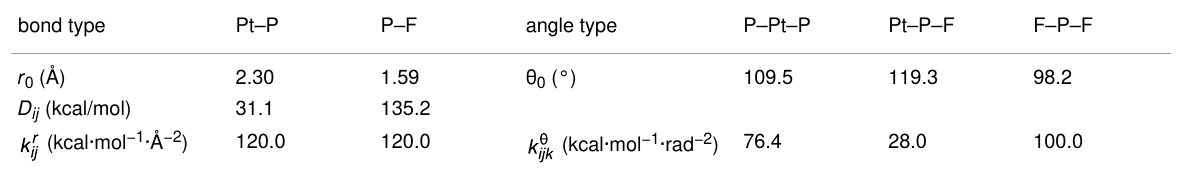
Table 1: Parameters of the covalent bonds and angular interactions for the Pt(PF 3 ) 4 molecule employed in the present simulations. bond